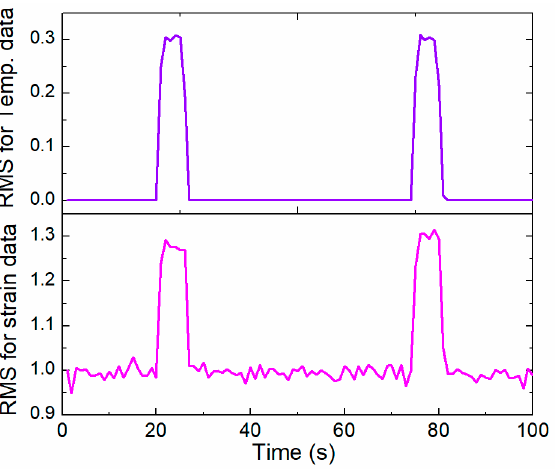
Figure 13. RMS value for the strain and temperature data extracted by the SPA.